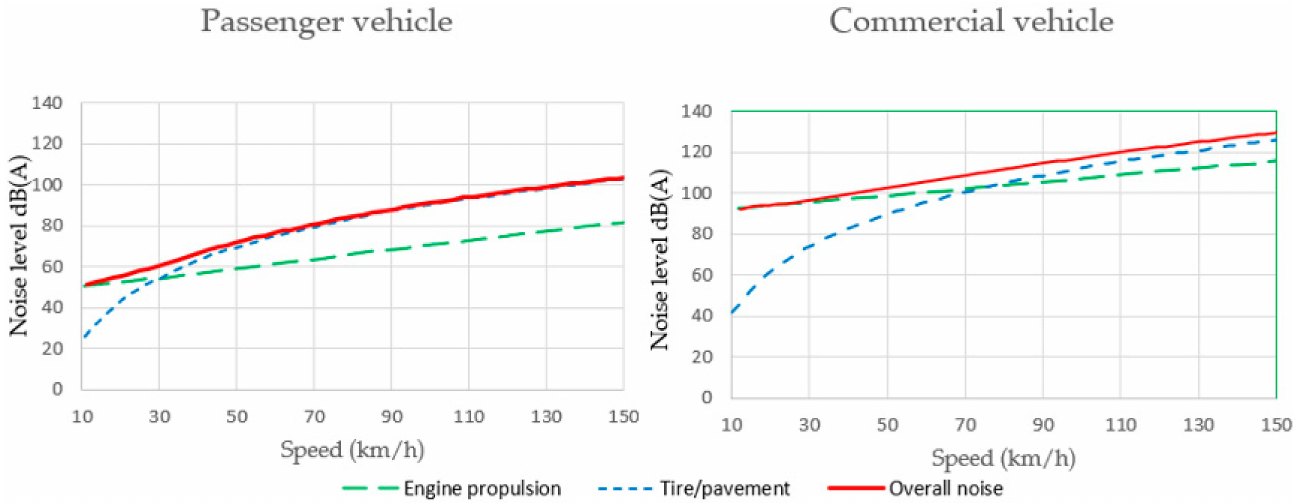
Figure 5. An estimate of passenger and commercial vehicle noise and its main sources (adapted from